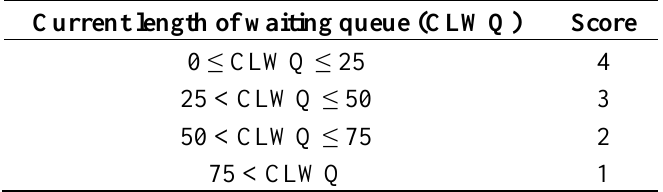
Table 4. The score table of current length of a waiting queue.